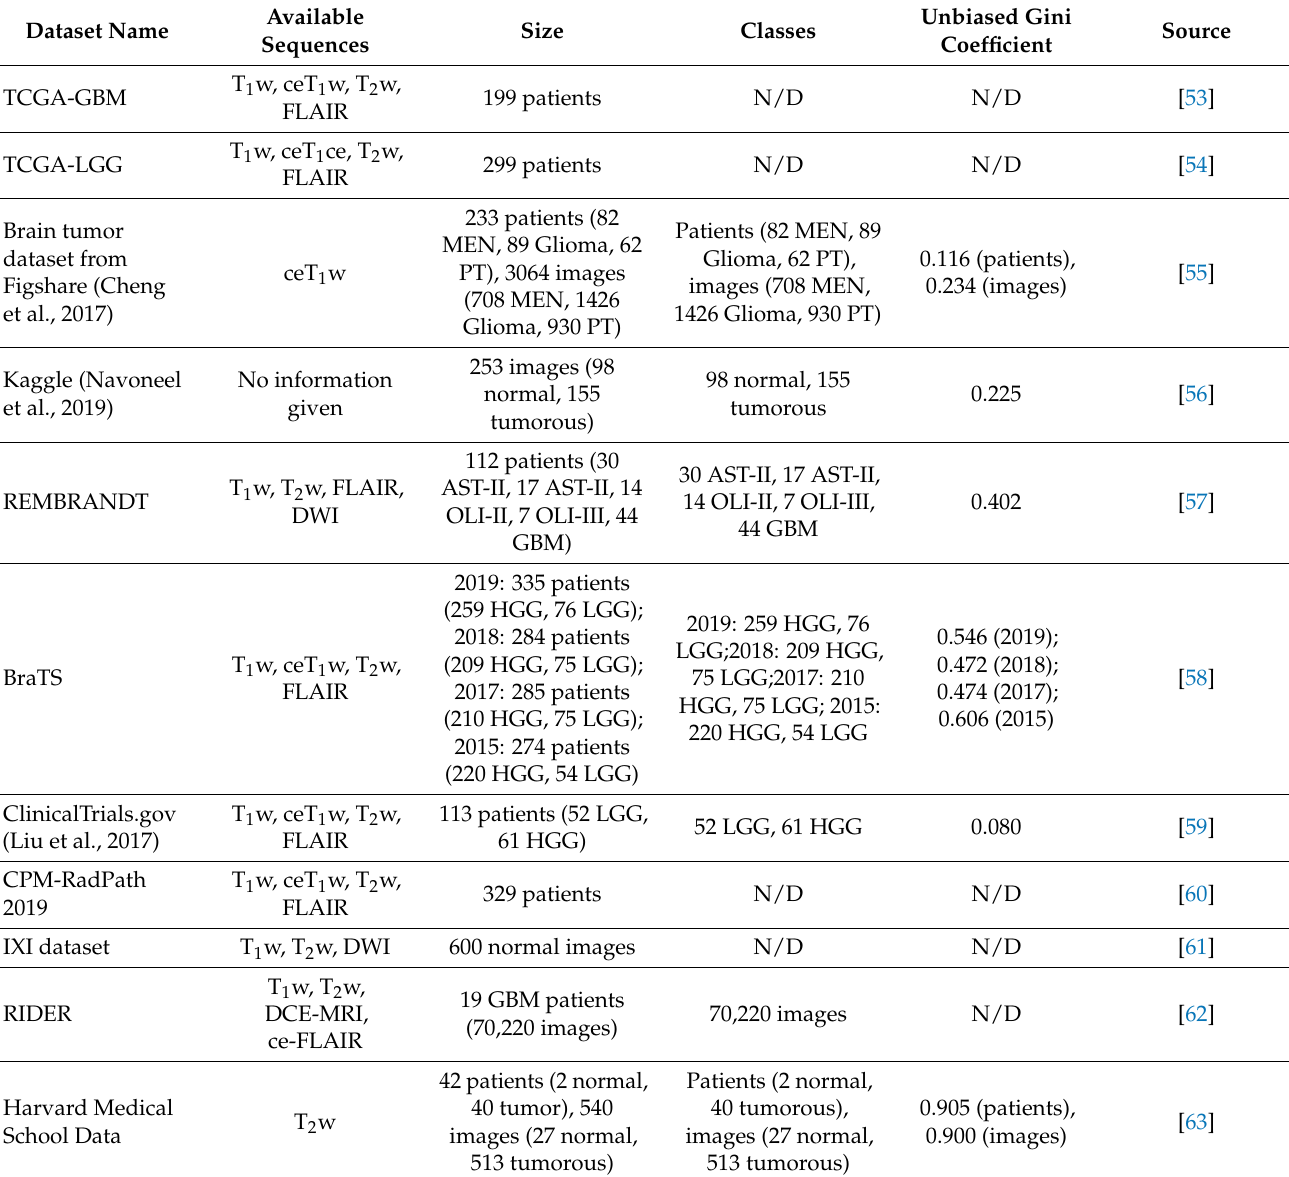
Table 2. An overview of publicly available